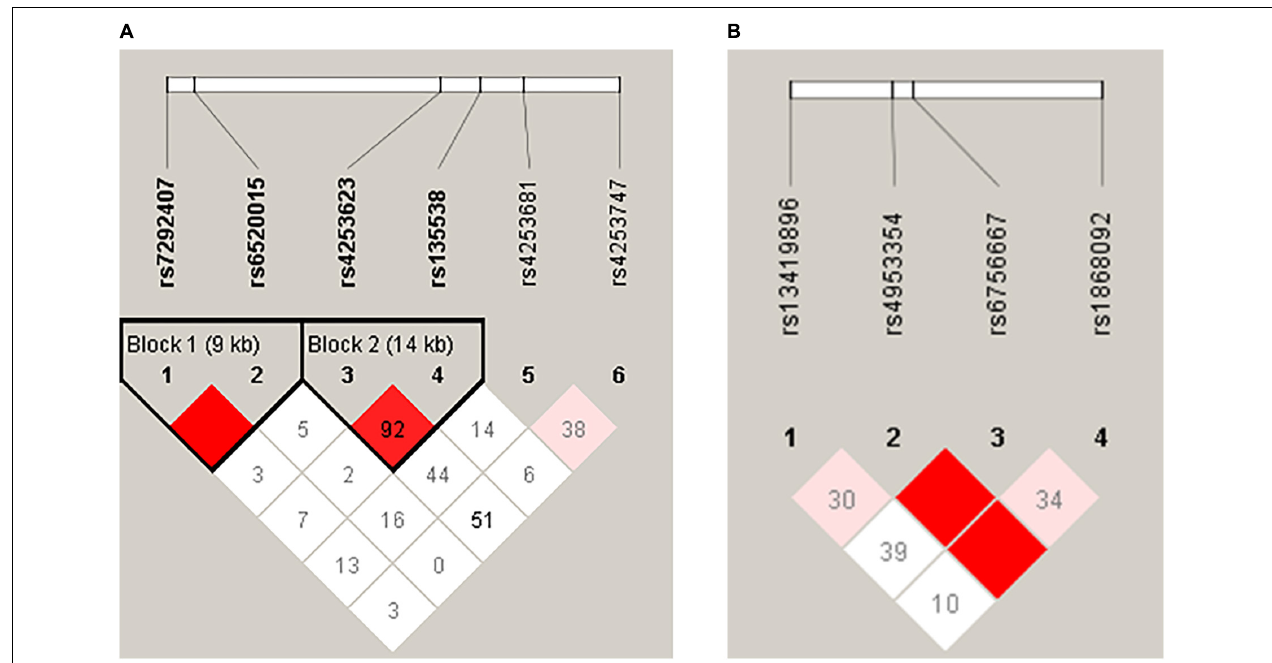
FIGURE 1 | Haplotype block map for SNPs of the PPARA (A) and EPAS1 (B)